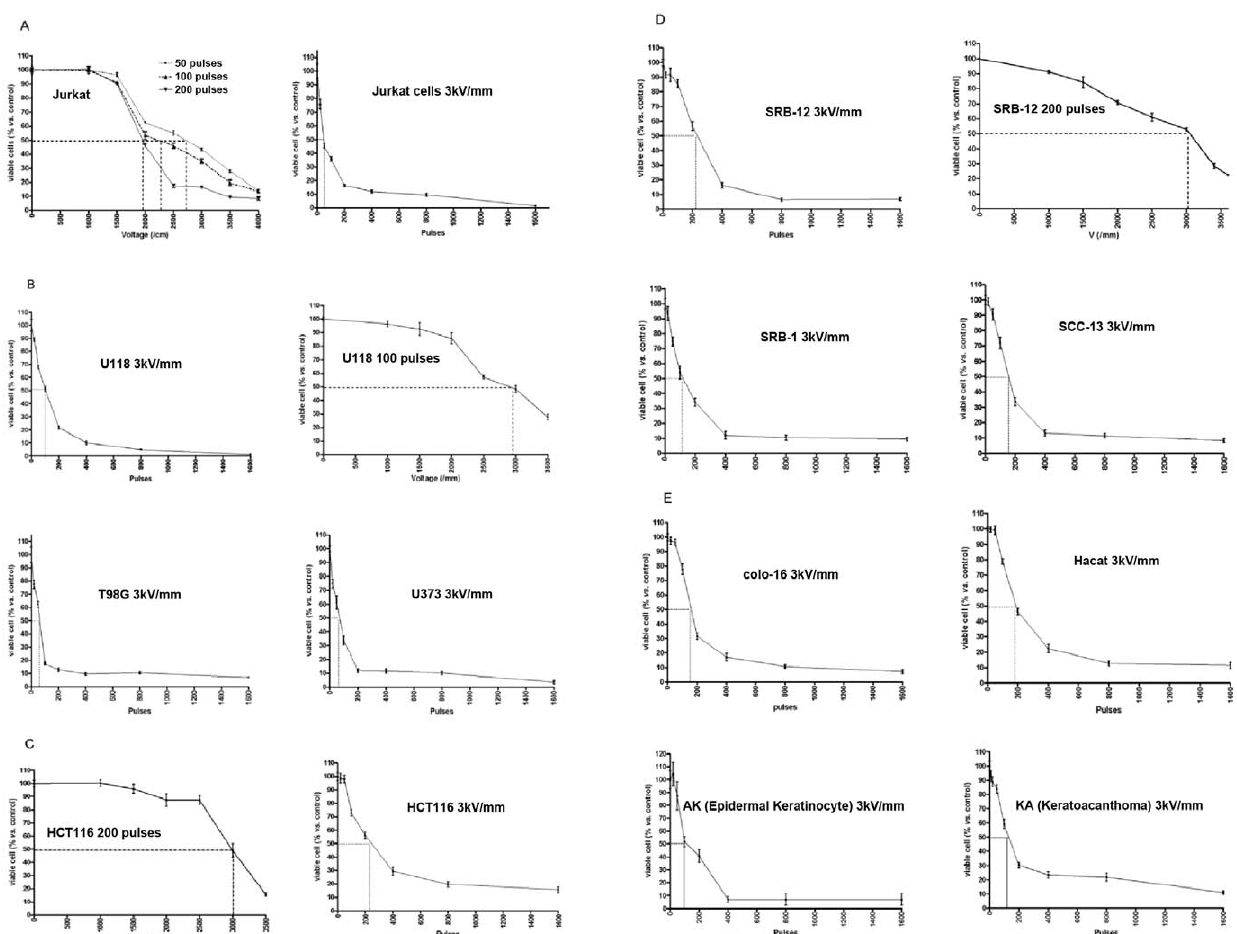
Figure 1. Treatment of cell lines invitro with nsPEF. nsPEF exposure of Jurkat cells (Human T cell leukemia, 2 6 10 6 /mL) to 50, 100 or 200 pulses of 30 ns duration, at 50 Hz and a varying peak voltage (Panel A, left), and at a fixed peak voltage resulting in a field of 30 kV/cm and a varying number of pulses (Panel A, right). nsPEF exposure of 11 solid tumor cell lines (2 6 10 6 /mL in 1 mm cuvette): glioblastoma multiforme (GBM) cells (U118, T98G, U373); colon cancer cells ( HCT116); skin cancer cells (SRB-1, SRB-12, SCC-13, Colo-16, HaCaT); as well as early transformed cells [AK (actinic keratosis), KA (keratoacanthoma)]. Cells were exposed to 100 or 200 pulses of 30 ns duration, at 50 Hz and a varying peak voltage, and at a fixed peak voltage resulting in a field of 30 kV/cm and a varying number of pulses (Panels B. C. D. E). The effect of nsPEF exposure on cell viability is represented by the percentage of viable cells remaining after exposure calculated as a fraction of viable control cells, not exposed but handled similarly. Trypan blue was used to measure viable cells after nsPEF exposure at one hour. The dashed lines indicate either the pulse number or peak voltage associated with a 50% (ED50) reduction in cell viability. Results are values obtained from three experiments under identical conditions (mean + SD).